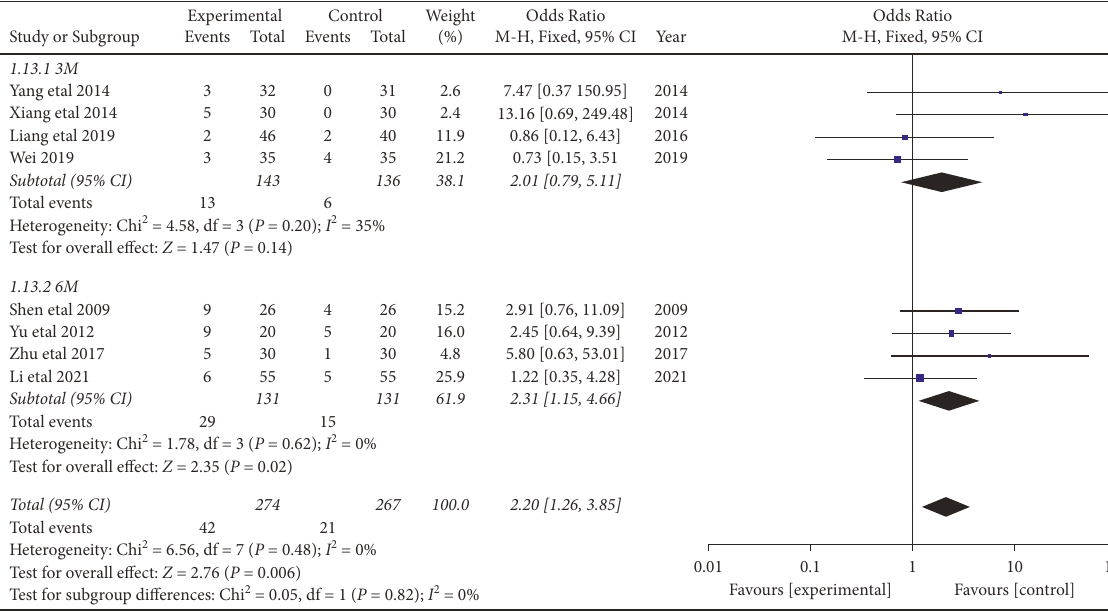
Figure 9: GTW combined with RASI versus control AE-3 months versus 6 months.